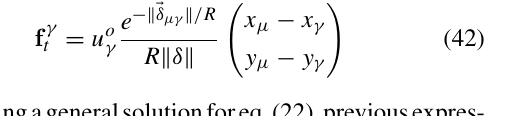
Table 8 Algorithm Attractive accelerative